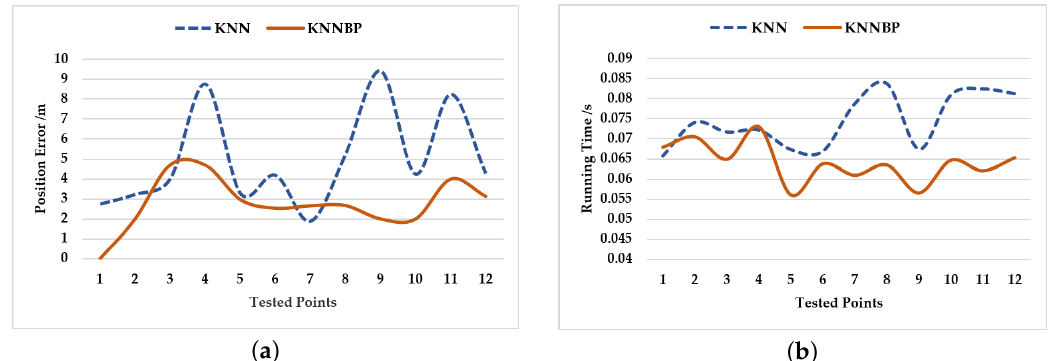
Figure 8. ( a ) Comparison of the positioning test between KNN and KNNBP. ( a ) Position error of rough localization according to KNN and KNNBP. ( b ) Running time for rough localization by KNN and KNNBP.